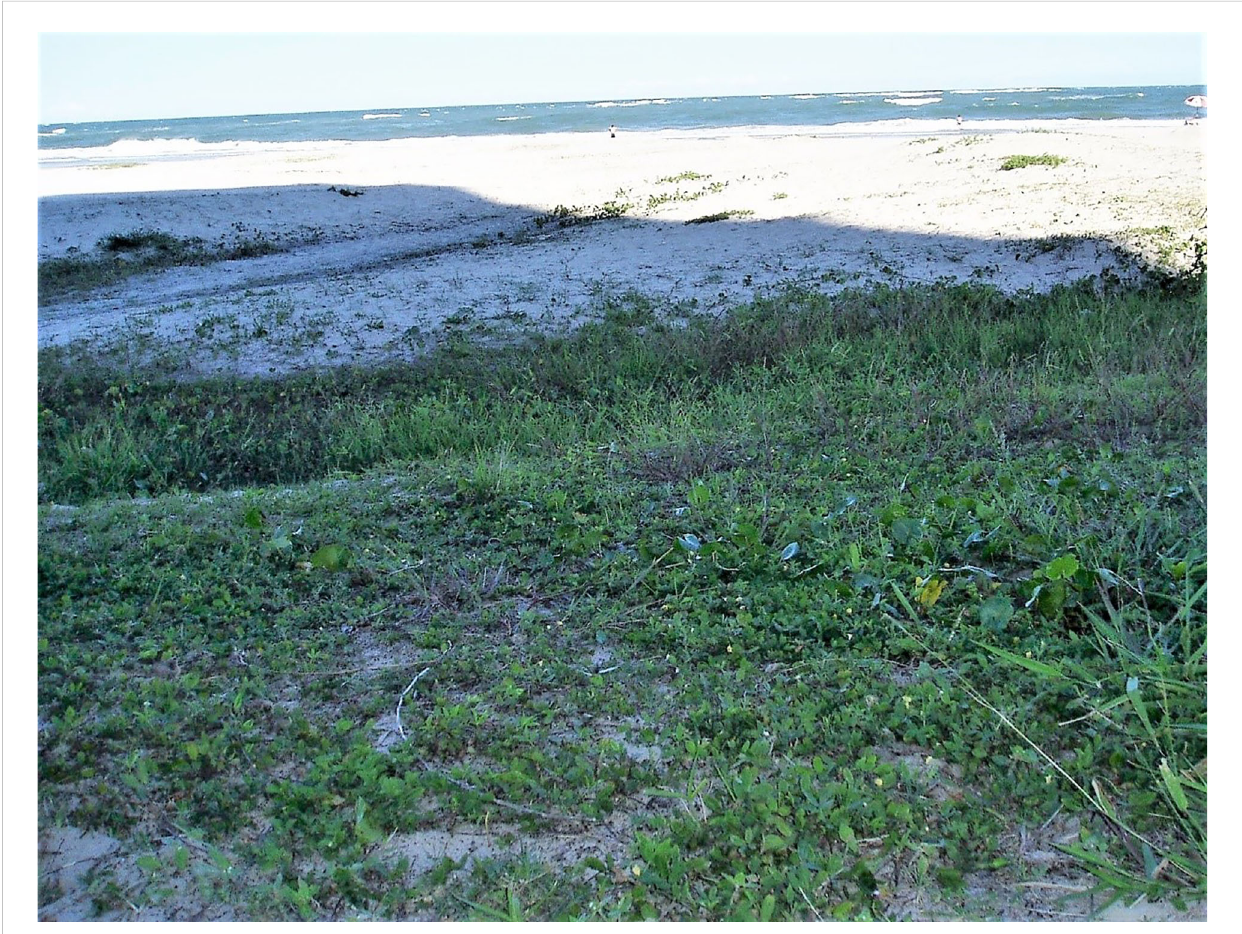
FIGURE 8 The accession A. stenosperma V 15076 growing in the place where it was collected, in Caioba ́ Beach, Parana ́ state. Note the pure sand where the plants were growing vigorously and the very close proximity to the sea. The photo was taken during its collection and kindly provided by the collector Jose ́